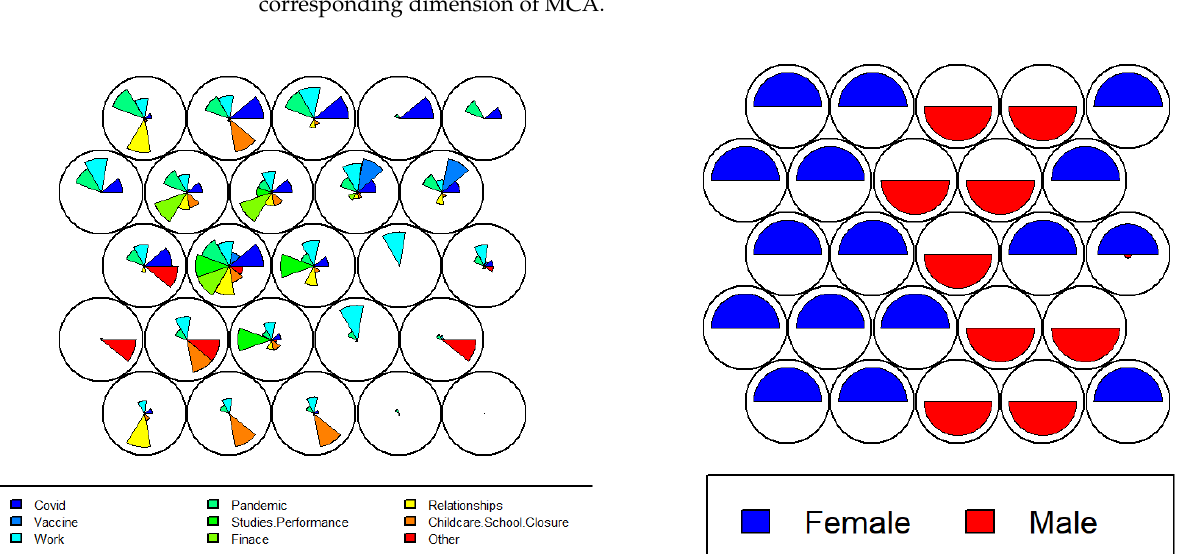
Figure 3. MCA outcomes (first two dimensions) indicating sex correspondence to major stress causes reported in public responses. The closer the attributes, the higher the correspondence and vice versa. Green to red ‘contrib’ colour scale indicates the contribution level being low to high, respectively, for corresponding dimension of MCA.